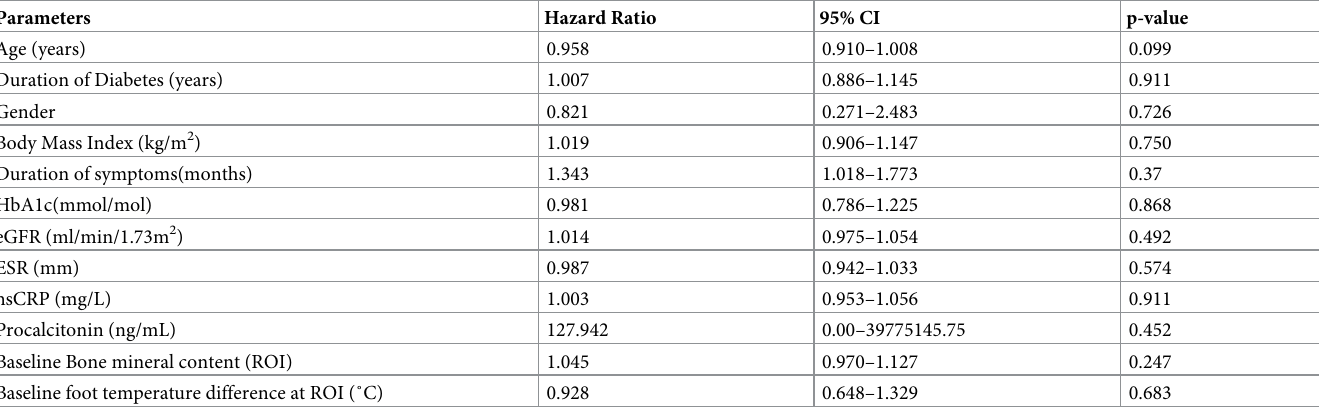
Table 2. Predictors of remission of active Charcot foot according to the baseline variables.